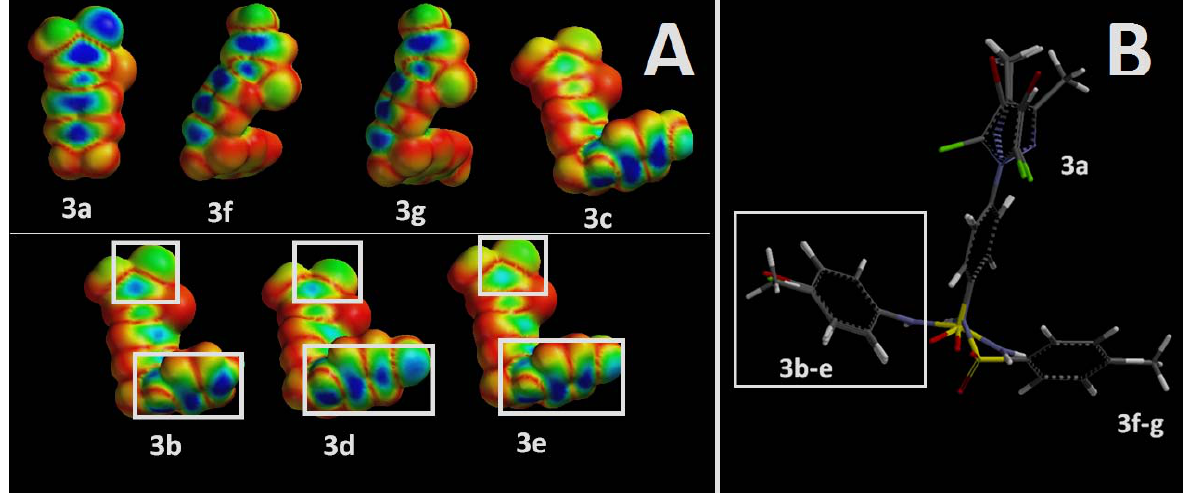
Figure 2. Theoretical structural analysis of the new 4-(1 H -pyrazol-1-yl)benzenesulfonamide series ( 3a – g ) using a molecular modeling approach. Comparison of the highest occupied molecular orbital (HOMO) distribution ( A ) and of the structural orientation through the superposition ( B ) of the less (compounds 3a , 3f , 3g and 3c ) and most active ( 3b – e ) compounds. The theoretical analysis allowed pointing derivatives electronic regions ( A ) and orientation ( B ) that are probably related with a better interaction with the parasitic target (white